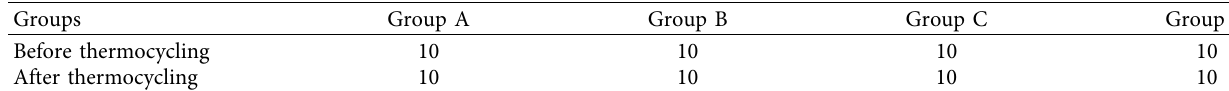
Table 2: Grouping of the tested samples.